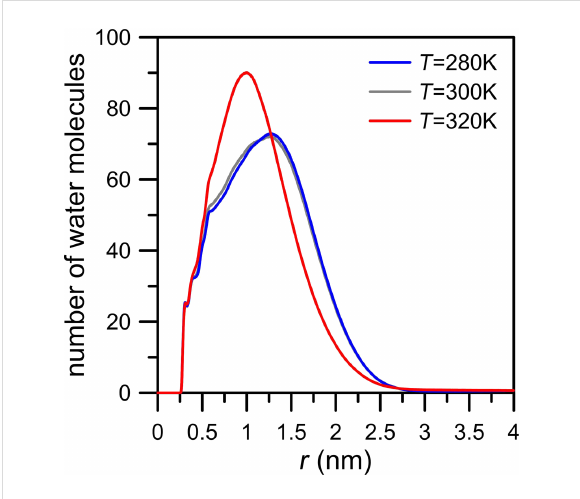
Figure 12: The temperature effect on the number of water molecules as a function of the distance of O w atoms from the center of the rim of an NN nanopore (defined as the geometric center of nitrogen atoms in the nanopore rim) calculated for a CH 4 + N 2 gaseous mixture contain- ing 200 water molecules. Other notes are the same as in Figure 4.